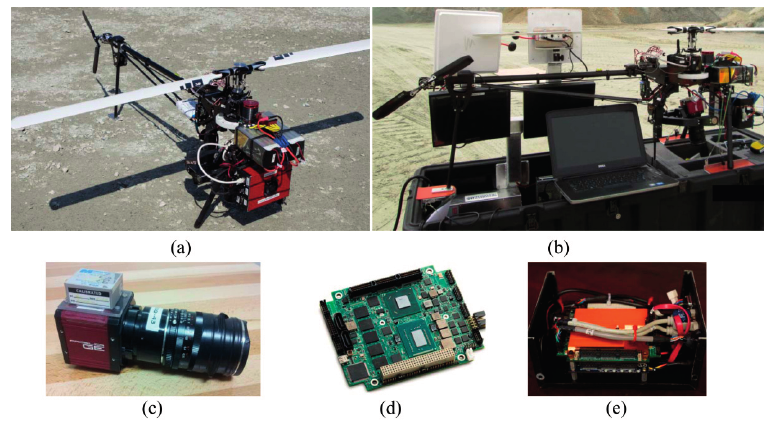
Figure 1. Equipment ( a ) Aerial platform; ( b ) Ground control station; ( c ) INS attached to camera; ( d ) Computer board; ( e ) Computer board and power supply stacked